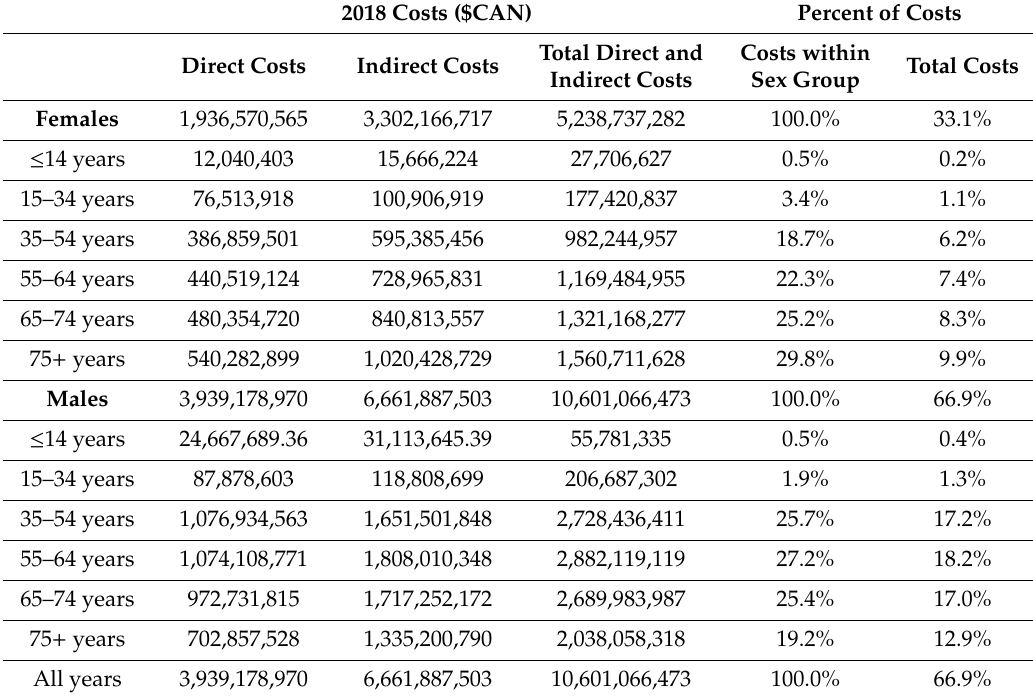
Table 5. Economic burden in Canada in 2018 by age and sex groups.